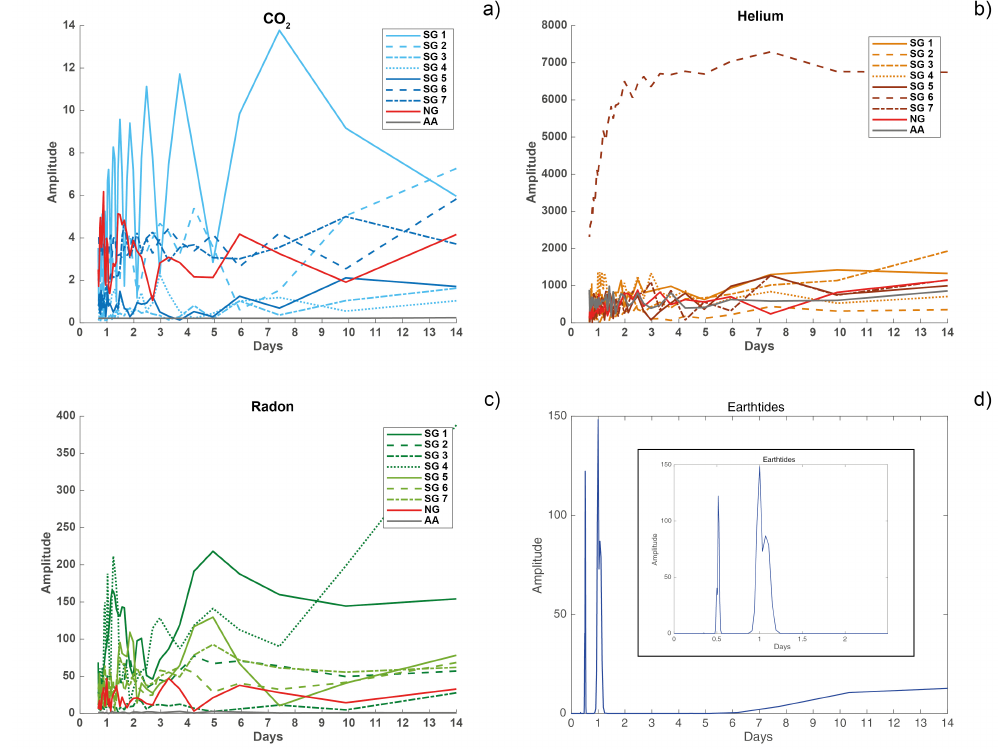
Figure 6. Results of the modified FFT (Fast Fourier Transform) analysis for the degassing patterns of ( a ) CO 2 , ( b ) He, ( c ) Rn in AA, NG and SG 1–SG7 in the 4-W samples and ( d ) earth